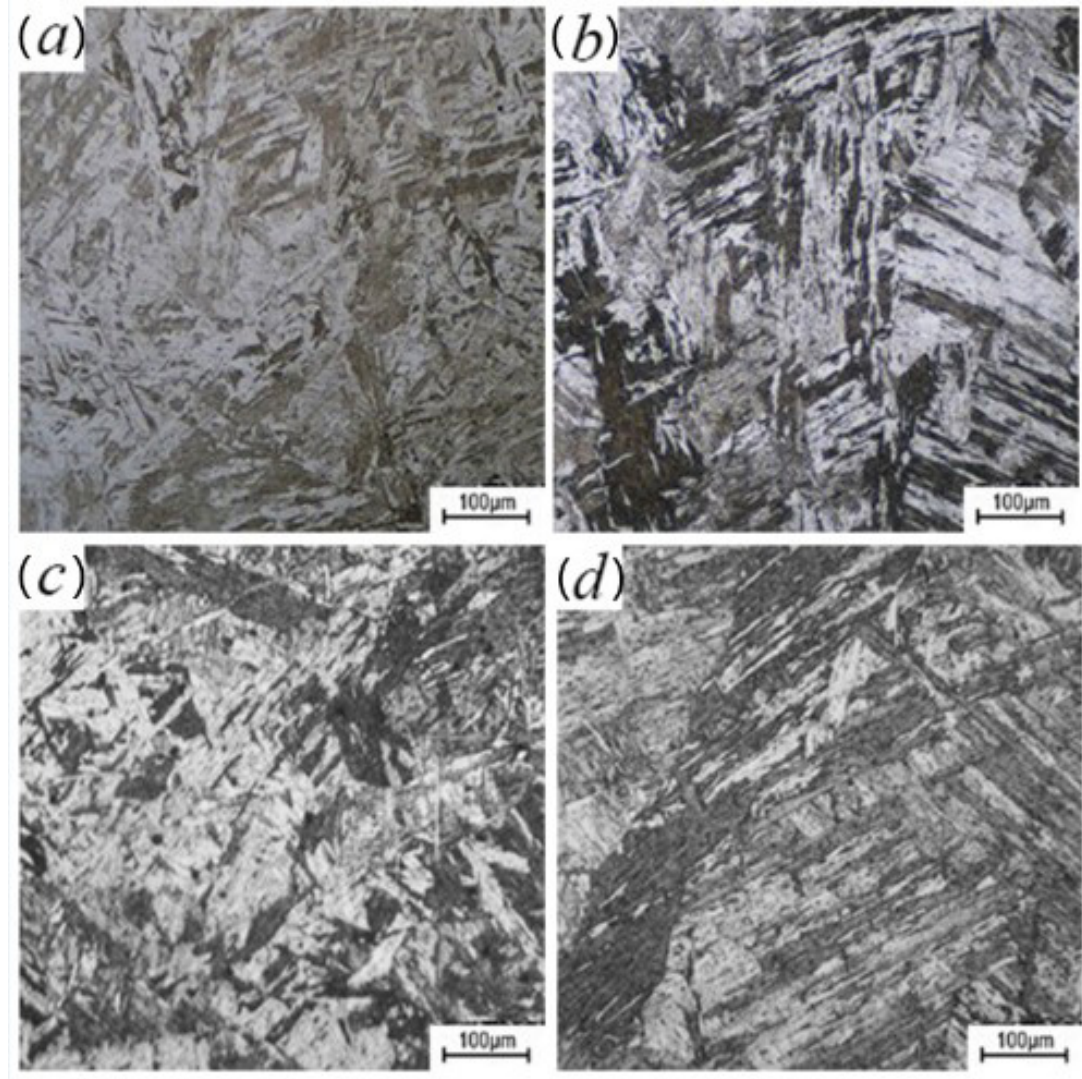
Figure 4. Microstructure in weld zone under different holding time: (a) unannealed, (b) 760°C+4h, (c) 760°C+5h, and